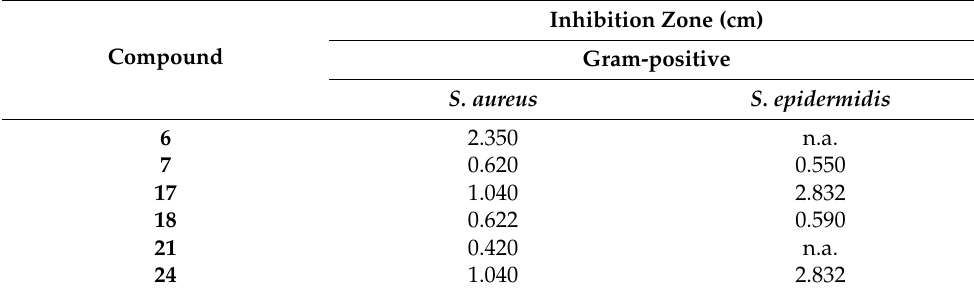
Table 2. Diameters of the inhibition zone of all the active compounds (15 nmol) against two Gram- positive bacterial strains.